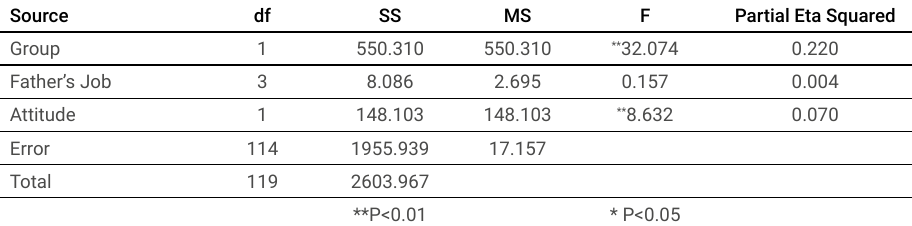
Table 4. Analysis of Covariance for the Effect of education on Attitude Source df